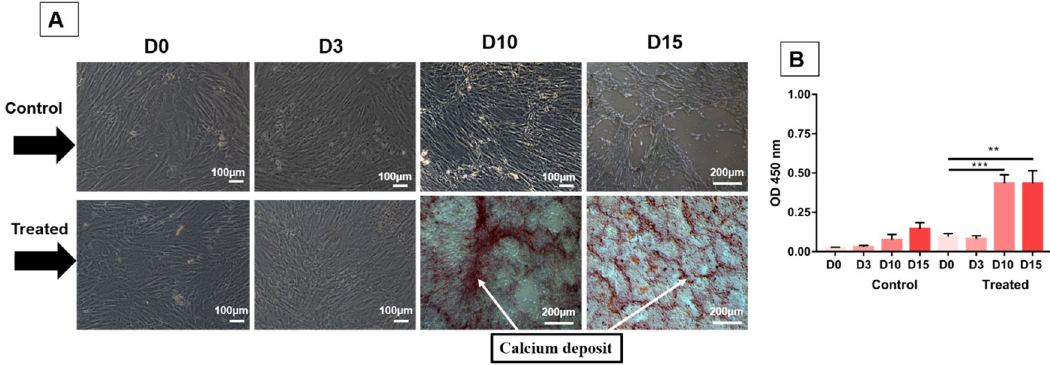
Fig. 6 Evolution of osteogenic differentiation by the alizarin red staining assay on days D0, D3, D10 and D15. A First line: cells treated with conventional medium. Second line: cells treated with conditioned